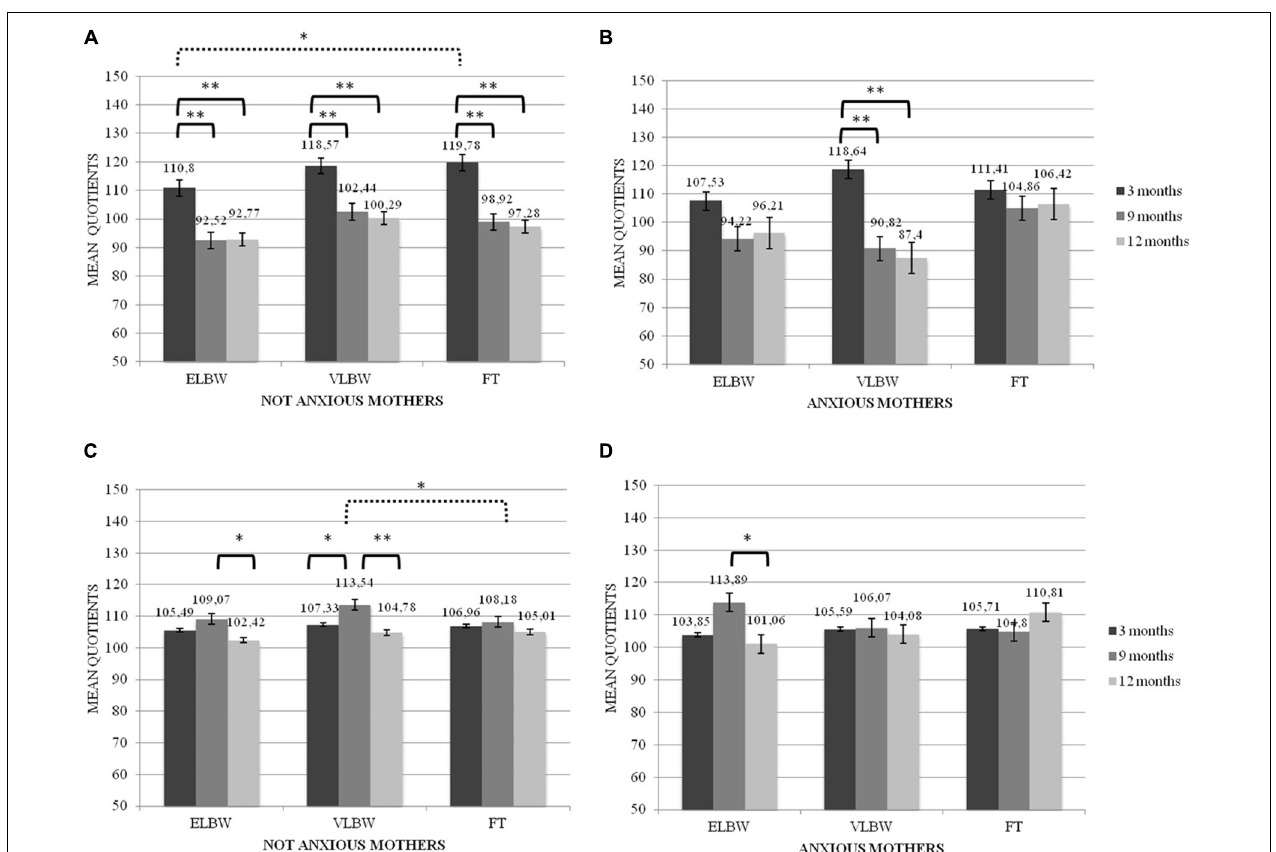
FIGURE 2 | Locomotor and Hearing and Language quotients according to the interaction between birth weight, maternal anxiety and tune of assessment. * p < 05; ** p < 0.005. (A) Locomotor mean Quotients in Not Anxious group, (B) Locomotor mean Quotients in Anxious group, (C) Hearing and Language mean Quotients in Not Anxious group, (D) Hearing and Language mean Quotients in Not Anxious group. Continue line denotes within group comparison, dotted line between group